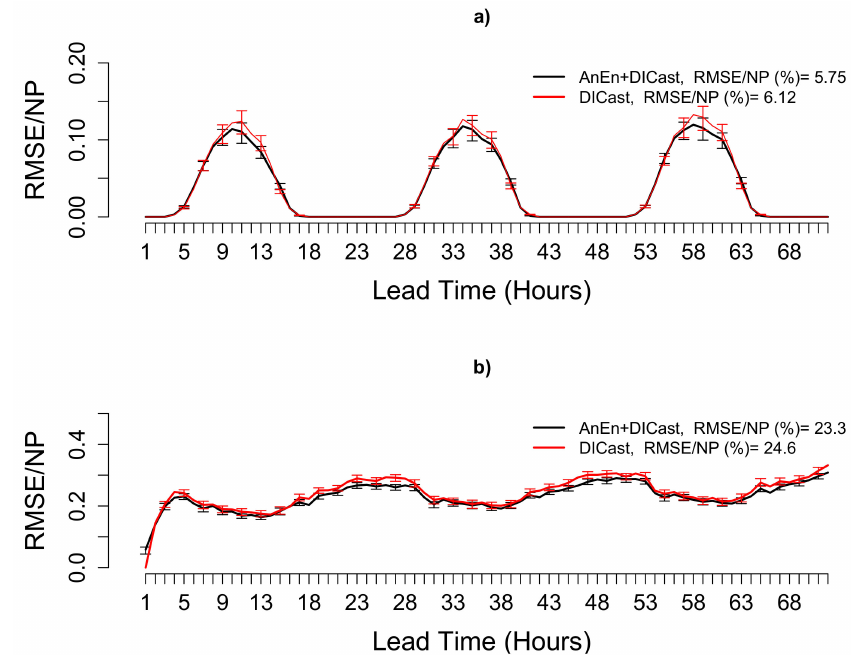
Figure 13. Root mean squared error for AnEn + DICast (black) and DICast (red) for solar power ( a ) and wind power ( b ). The vertical bars represent the 5%–95% bootstrap intervals that are plotted every other lead time to reduce clutter. RMSE values are normalized by the nominal power of a single turbine (2 MW) or of a single PV plant (5 MW) and they are obtained by pooling data from all wind turbines or solar plants together. The values in the legends are obtained by averaging over the lead times and are shown as a